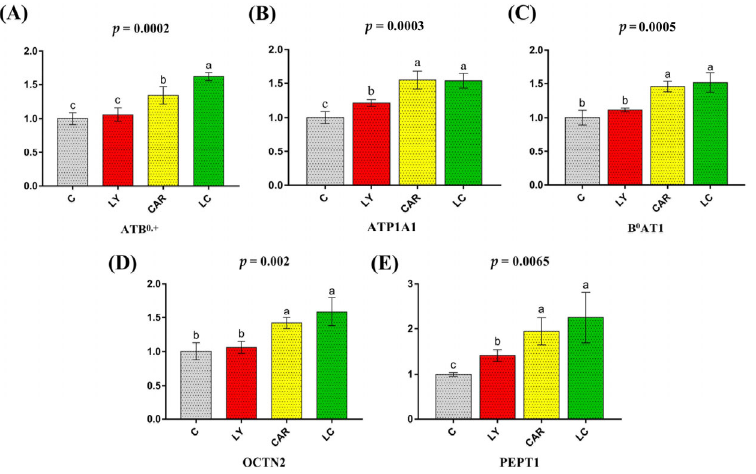
Figure 2. Relative mRNA expression of candidate nutritional transport genes in the duodenum. ( A ), ATB 0,+ ; ( B ), ATP1A1; ( C ), B 0 AT1; ( D ), OCTN2; ( E ), PEPT1. Data are presented as mean value ± SEM ( n = 3). Values without the same letter (a, b,c) represent statistically significant differences ( p < 0.05). Abbreviations: C, Roosters fed a basal diet; LY, Roosters fed a basal diet supplemented with 400 mg/kg Lycopene; CAR, Roosters fed a basal diet supplemented with 150 mg/kg L ‐ Carnitine; LC, Roosters fed a basal diet supplemented with (400 + 150) mg/kg Lycopene and L ‐ Carnitine in combi ‐ nation.